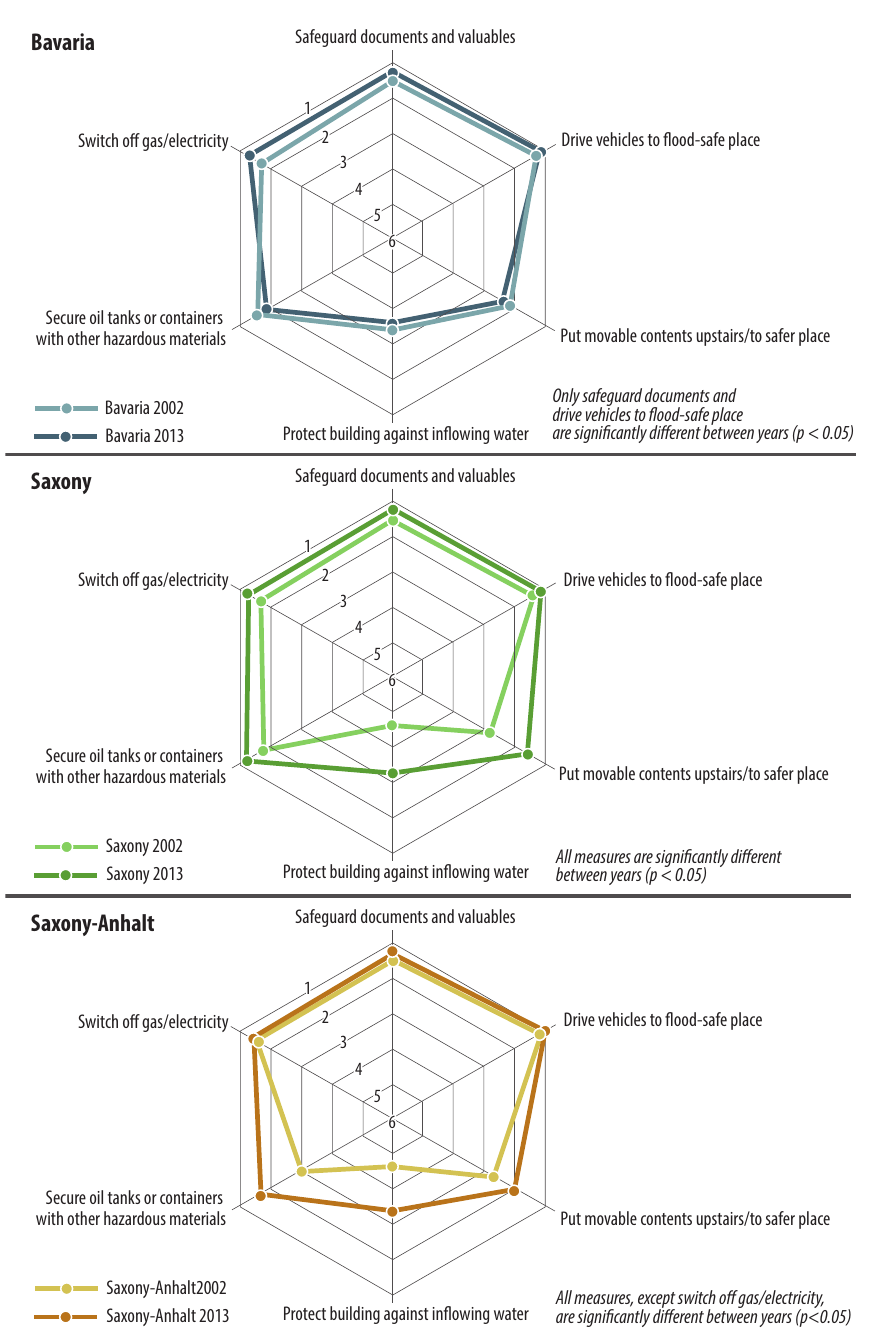
Figure 8. Self-perceived effectiveness of undertaken emergency measures by interviewed households in Bavaria, Saxony and Saxony-Anhalt (1 means very effective and 6 means not effective at